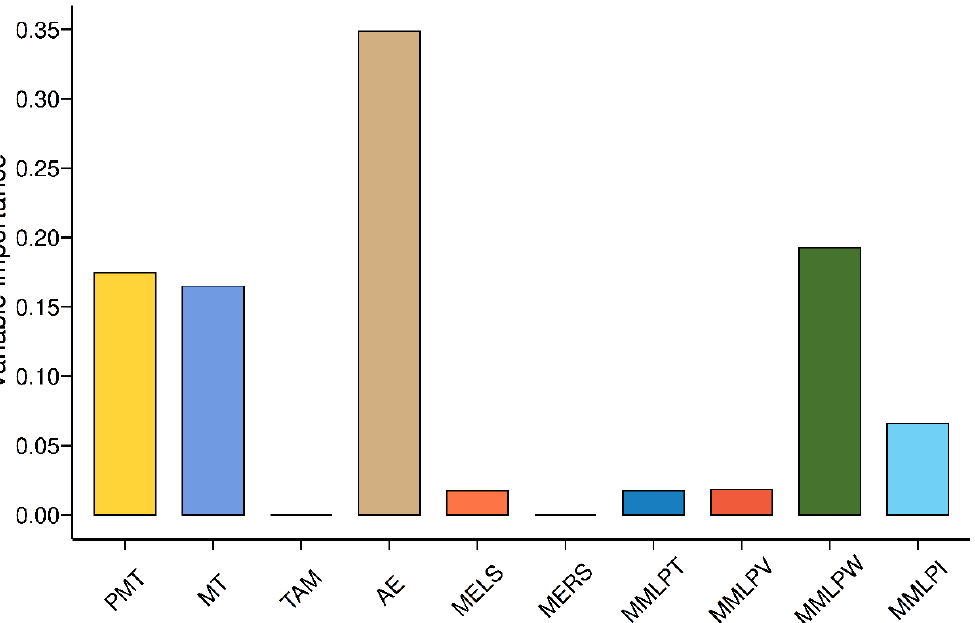
Figure 3. Variable importance measurement based on the RFT model for the Glutopeak test and mixograph results according to the addition of modified starches. PMT = peak maximum time, MT = maximum torque, TAM = torque after maximum, AE = aggregation energy, MELS = mixograph envelope left slope, MERS = mixograph envelope right slope, MMLPT = mixograph MID line peak time, MMLPV = mixograph MID line peak value, MMLPW = mixograph MID line peak width, MMLPI = mixograph MID line peak integral.